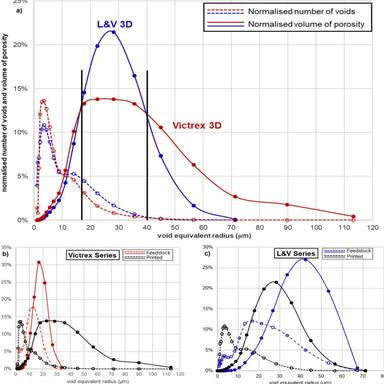
Void size distribution plots for a) Printed samples; vertical continuous black lines indicate voids with radius equal to 16 and 40 µm; b) Feedstock and Victrex 3D; c) Feedstock and L&V 3D; see text for more details.